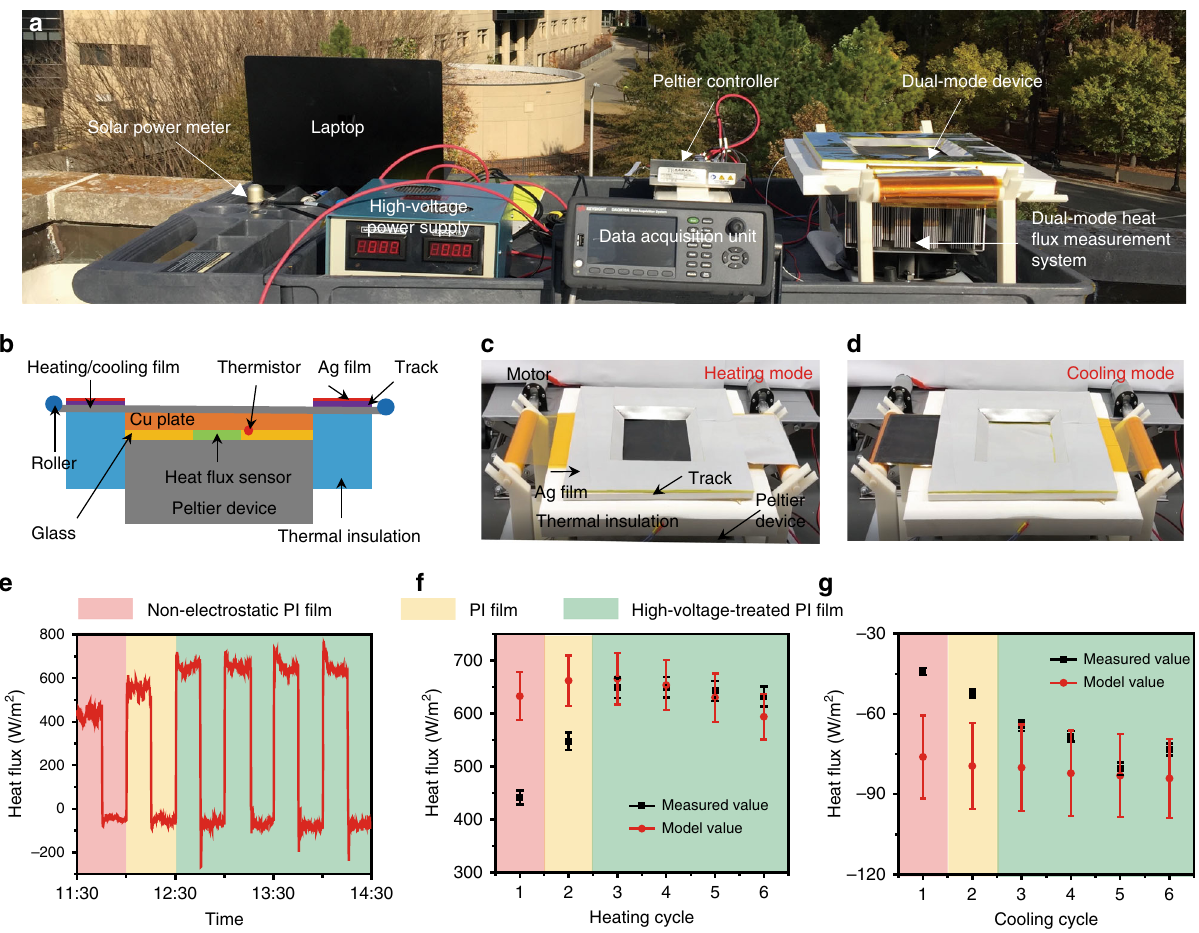
Fig. 4 Testing system and outdoor real-time performance of the dual-mode device. a Photo of the overall testing system. b Schematic and c , d photo of the dual-mode heat fl ux measurement device with heating mode and cooling mode. e Measured heat fl ux during the testing period. Positive values represent heating. For comparison, the fi rst cycle (red area) was performed using a non-electrostatic PI fi lm, the second cycle (yellow area) used PI fi lm without external voltage, and the rest of the cycles (green area) used PI fi lm with external voltage supply. The ef fi cacy of Maxwell pressure-induced thermal contact is clearly shown. f Average solar heating heat fl ux over cycles. g Average radiative cooling heat fl ux over cycles. The error bars re fl ect the measurement solar energy is utilized. Similarly, in cooling cycles, as shown in Fig. 4g, the average cooling heat fl uxes of non-electrostatic PI and zero-external-voltage PI are 44.1 ± 1.3 and 52.5 ± 1.6 W/m 2 , which are 58% and 66% of the model values (76.1 ± 15.5 and 79.5 ± 16.1 W/m 2 , respectively). After applying high voltage, the measurement (average cooling power is about 71.6 W/m 2 ) and model match well. More details about model calculation can be found in Supplementary Note 3. This experiment clearly demonstrates the effectiveness of using electrostatic force to build the thermal contact between the dual-mode material and the object and how it can boost the performance approaching the